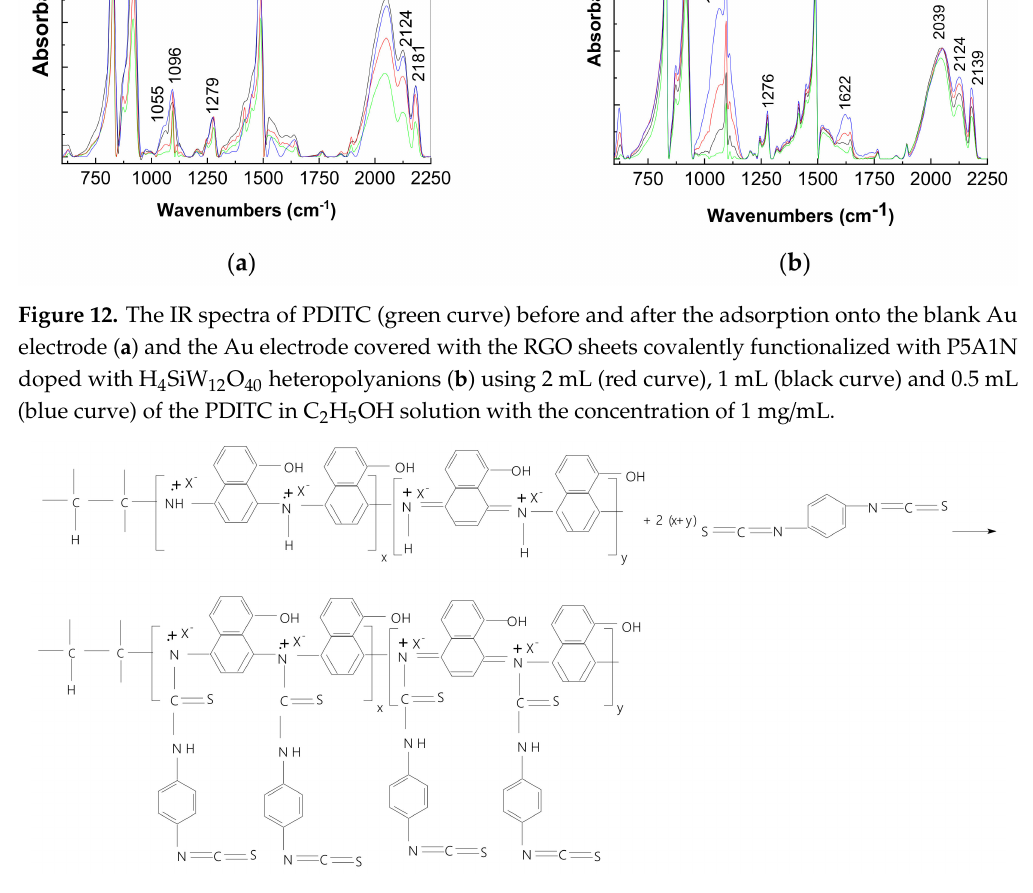
Scheme 3. The chemical interaction of PDITC onto the RGO sheets covalently functionalized with P5A1N doped with H 4 SiW 12 O 40 heteropolyanions. In this scheme, x and y correspond to the number of the reduced and oxidized entities of repeating units of macromolecular